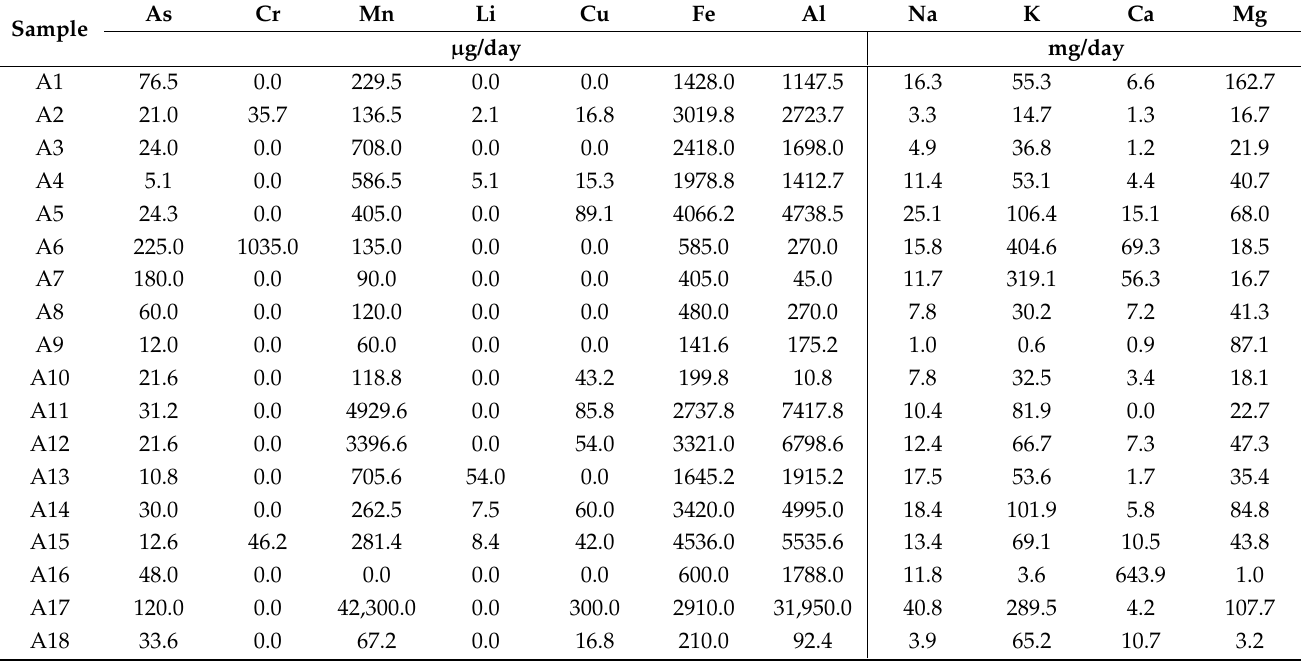
Table 6. The cumulative daily exposure dose for each element studied in the herbal weight loss